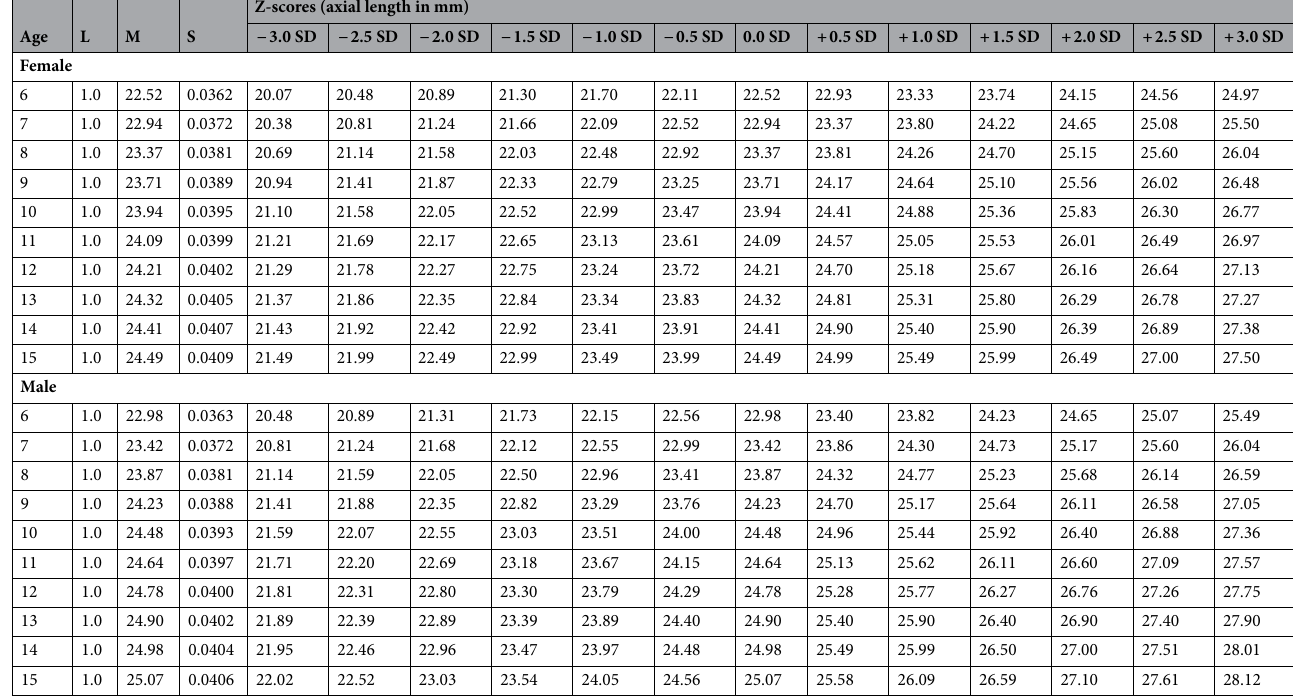
Table 3. LMS parameters and axial length Z-scores in millimeters, as a function of age and